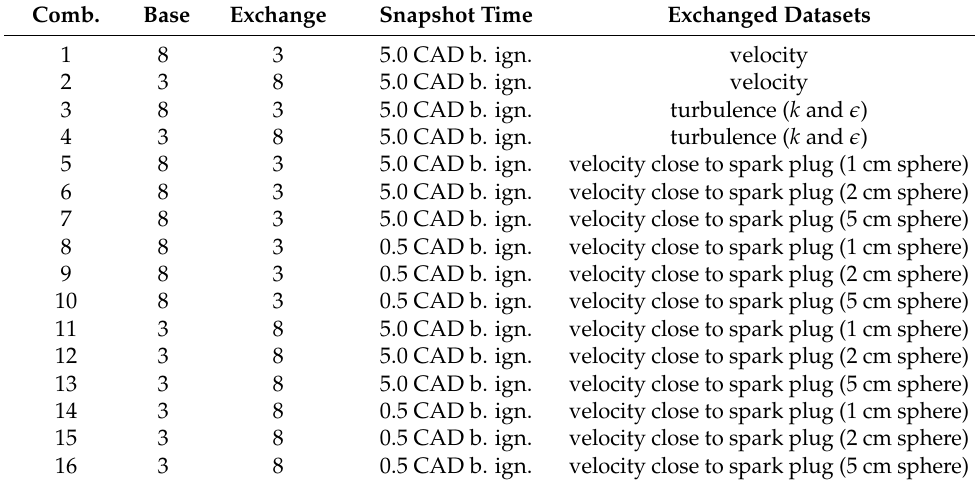
Table 1. Overview of the different restart combinations.